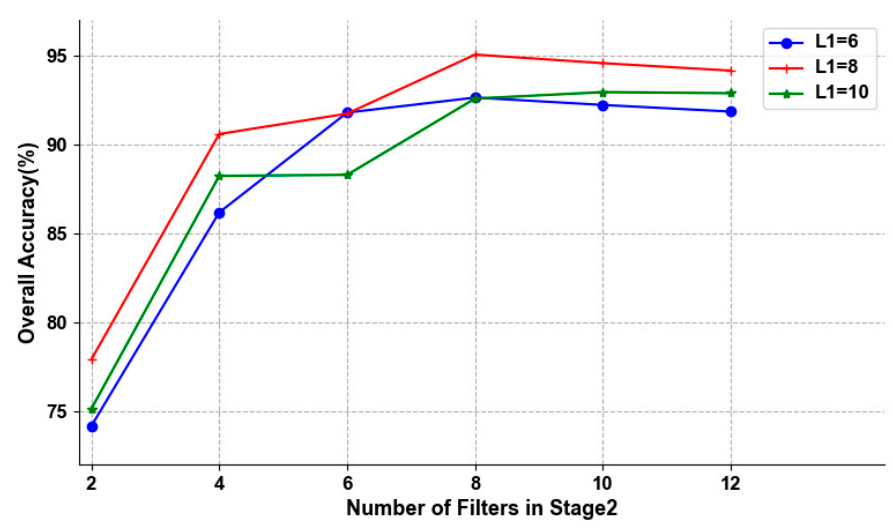
Figure 8. The influence of different numbers of filters on the classification accuracy.